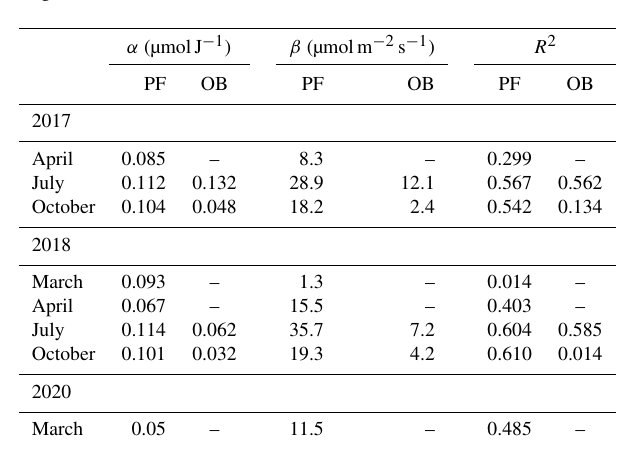
Table 6. Parameters α and β of the light response curves (Eq. 3) and R 2 ( p < 0 . 01) for March, April, July, and October in 2017, 2018, and 2020 at the paludified forest (PF) and the ombrotrophic bog (OB).